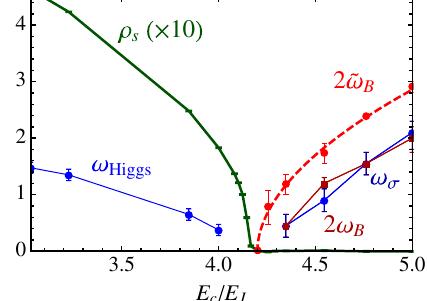
FIG. 2. Energy scales, in units of E J , as a function of the control parameter E c =E J in the clean system. From the SC side, the superfluid stiffness ρ s and the Higgs “ mass ” ω the insulating side, the optical conductivity threshold ω σ and the boson-energy scales ω B and ~ ω B , vanish at the transition, creating a fan-shaped region where quantum critical fluctuations dominate.